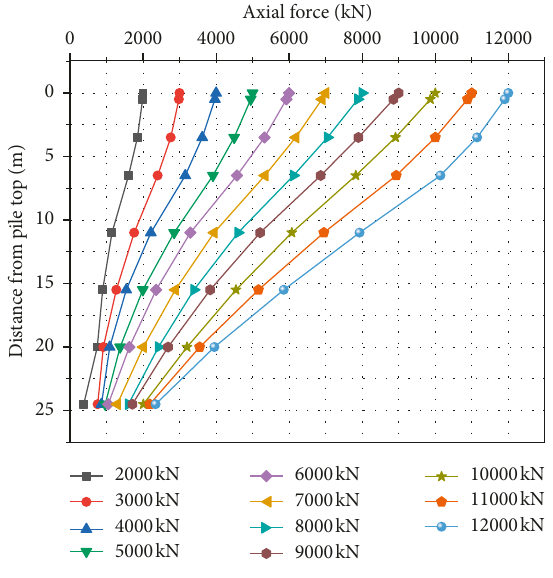
Figure 8: The axial force of RDP.